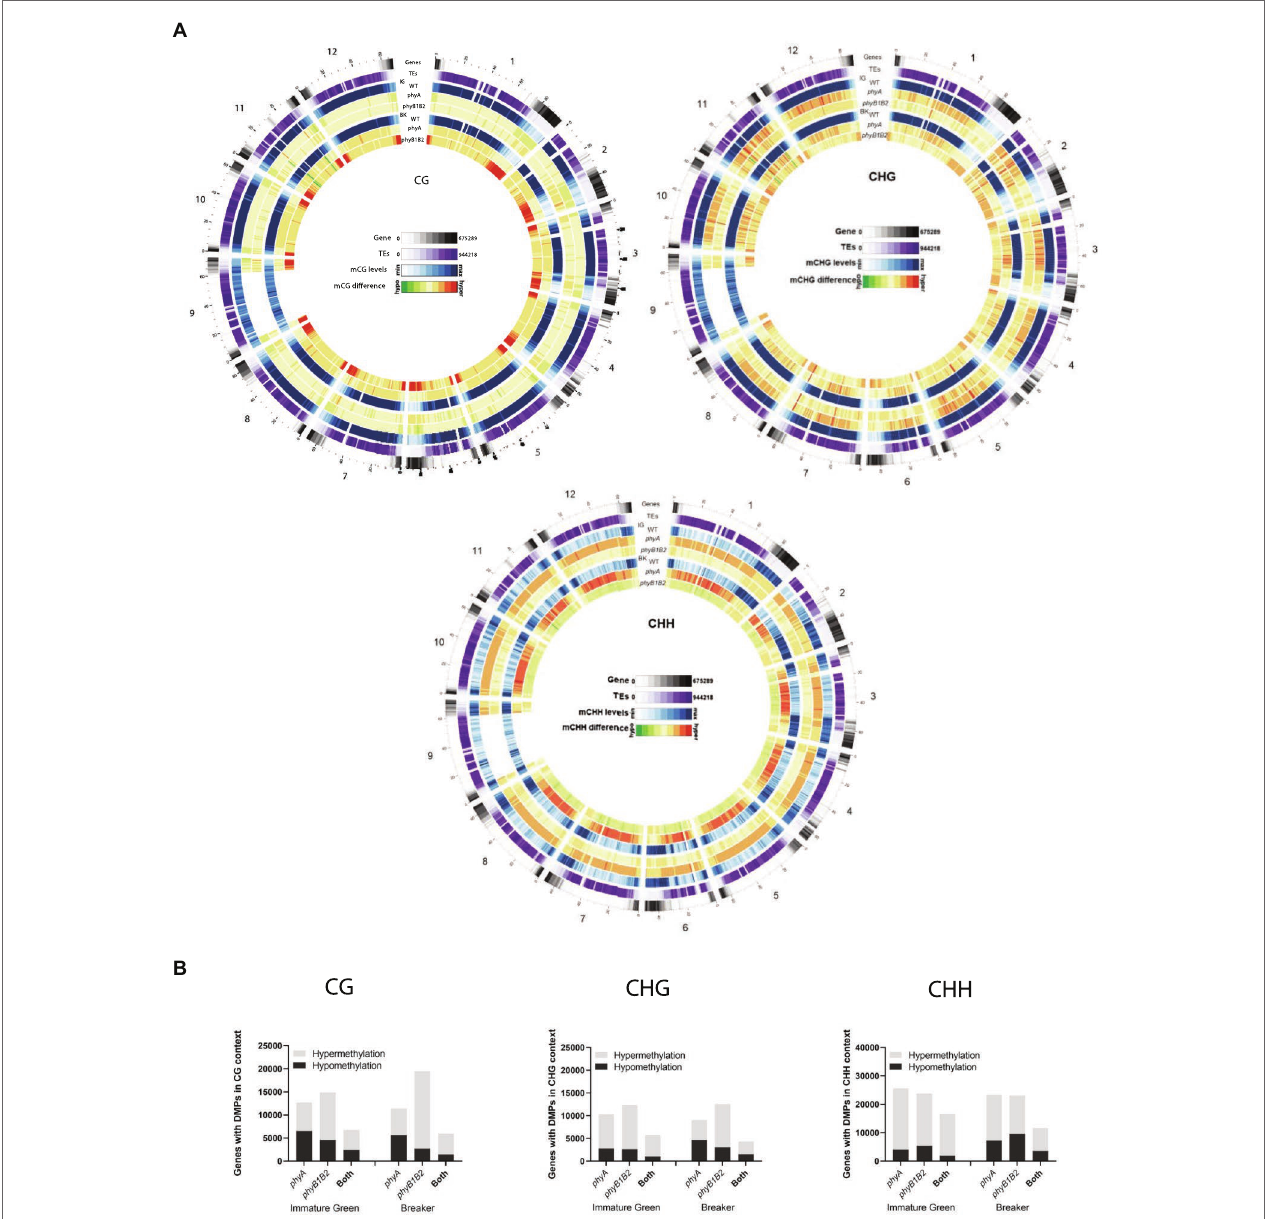
FIGURE 2 | Disturbed PHYA- and PHYB1B2-dependent signaling differentially alters tomato fruit methylome. (A) Density plot of genes, transposable elements (TEs) and mC in all contexts (mCG, mCHG, and mCHH) for the wild type (WT) genotype. Global methylation changes for phyA and phyB1B2 in comparison with the WT at the immature green (IG) and breaker (BK) stages are shown (bin size, 1 Mb). Gene and TE densities were estimated according to the number of nucleotides covered per million. The methylation levels in the CG, CHG and CHH contexts are 40%–90%, 25%–80%, and 10%–30%, respectively. The mC difference is relative to the corresponding WT fruit stage within a − 5% (hypomethylated) ≤ range ≤ +5% (hypermethylated). Chromosome scale (Mb) is shown. (B) Number of genes with differentially methylated promoters (DMPs, 2 kb upstream transcription start site) in phyA , phyB1B2 and common in both mutants, compared to WT. Hyper- and hypomethylation are indicated by grey and darker-colored bars, respectively. DMPs show statistically significant differences (FDR < 0.05) relative to